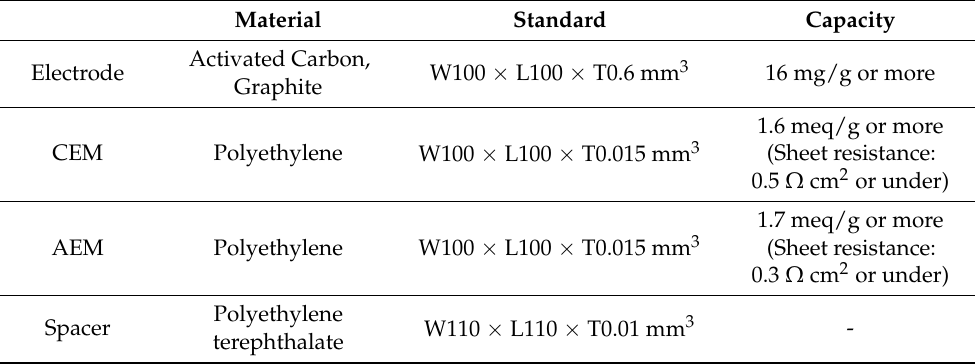
Table 1. Summary of MCDI module specification.